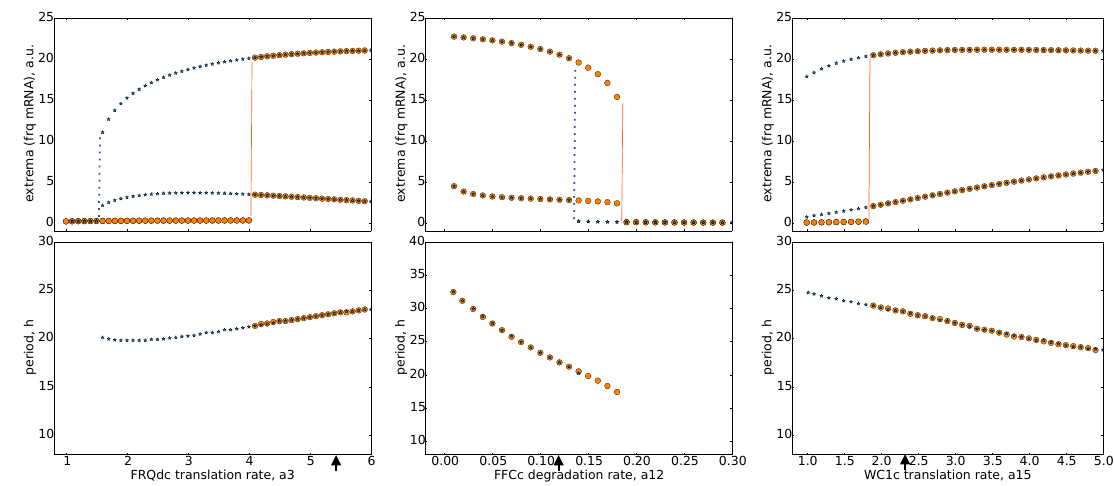
Figure A2. Co-existence of attractors: Bifurcation analysis of three parameters shows the co-existence of the limit cycle and steady state while the parameter is slowly varied. The values for increasing parameters are marked by orange circles. Decreasing parameters correspond to blue stars. Red lines mark jumps between steady states (low frq values) to limit cycle oscillations. The associated periods are given in the lower graphs. Default parameter values are marked by arrows.